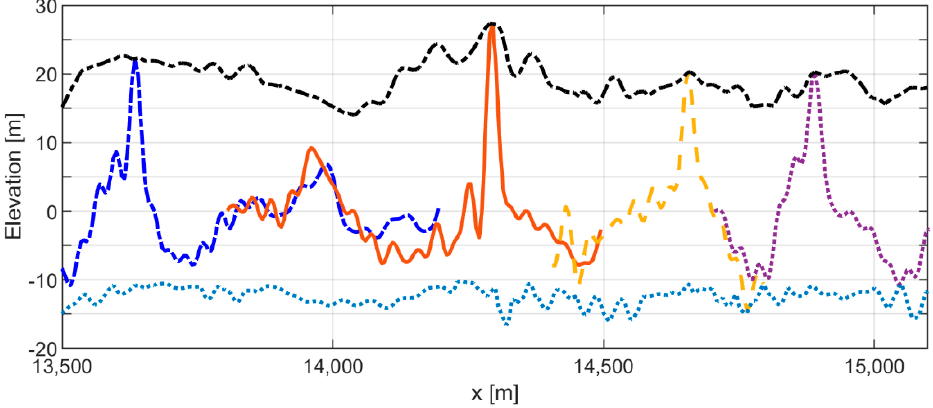
Figure 19. The four successive freak wave heights observed in the simulation without breaking, shown with parts of their profile at different appearance times.